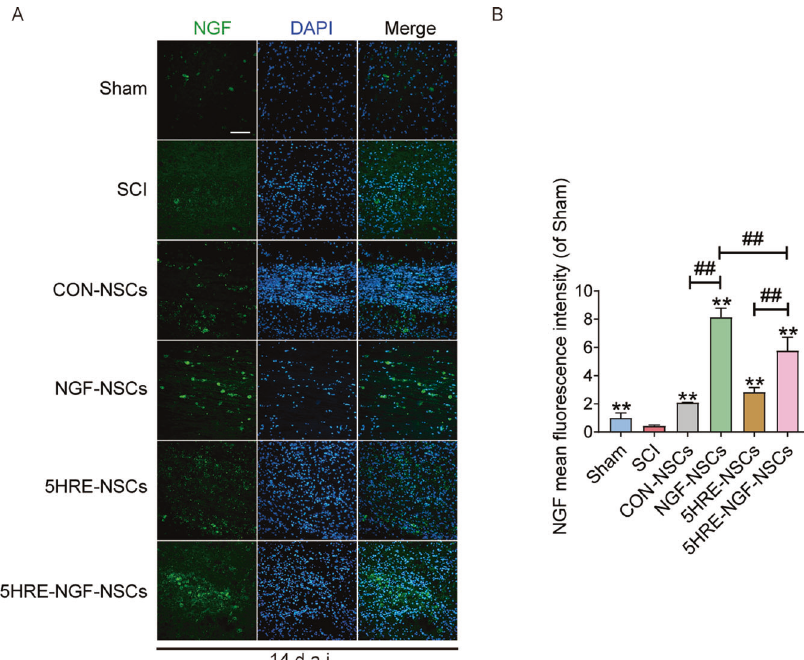
Fig. 2 NGF-NSCs group and corresponding hypoxia regulated expressed the higher NGF than other groups, as the former was the highest at the day of 14. A NGF staining of the Sham, SCI, CON-NSCs, NGF-NSCs, 5HRE-NSCs, and 5HRE-NGF-NSCs group. The light green parts are NGF + stained neurons, the nuclei are labeled by DAPI (blue). Magni fi cation was ×20. B Analysis of positive cells in immuno fl uorescence staining. ** signify P < 0.01 versus the SCI group, ## signify P < 0.01. Data are the mean values ± SD, n =